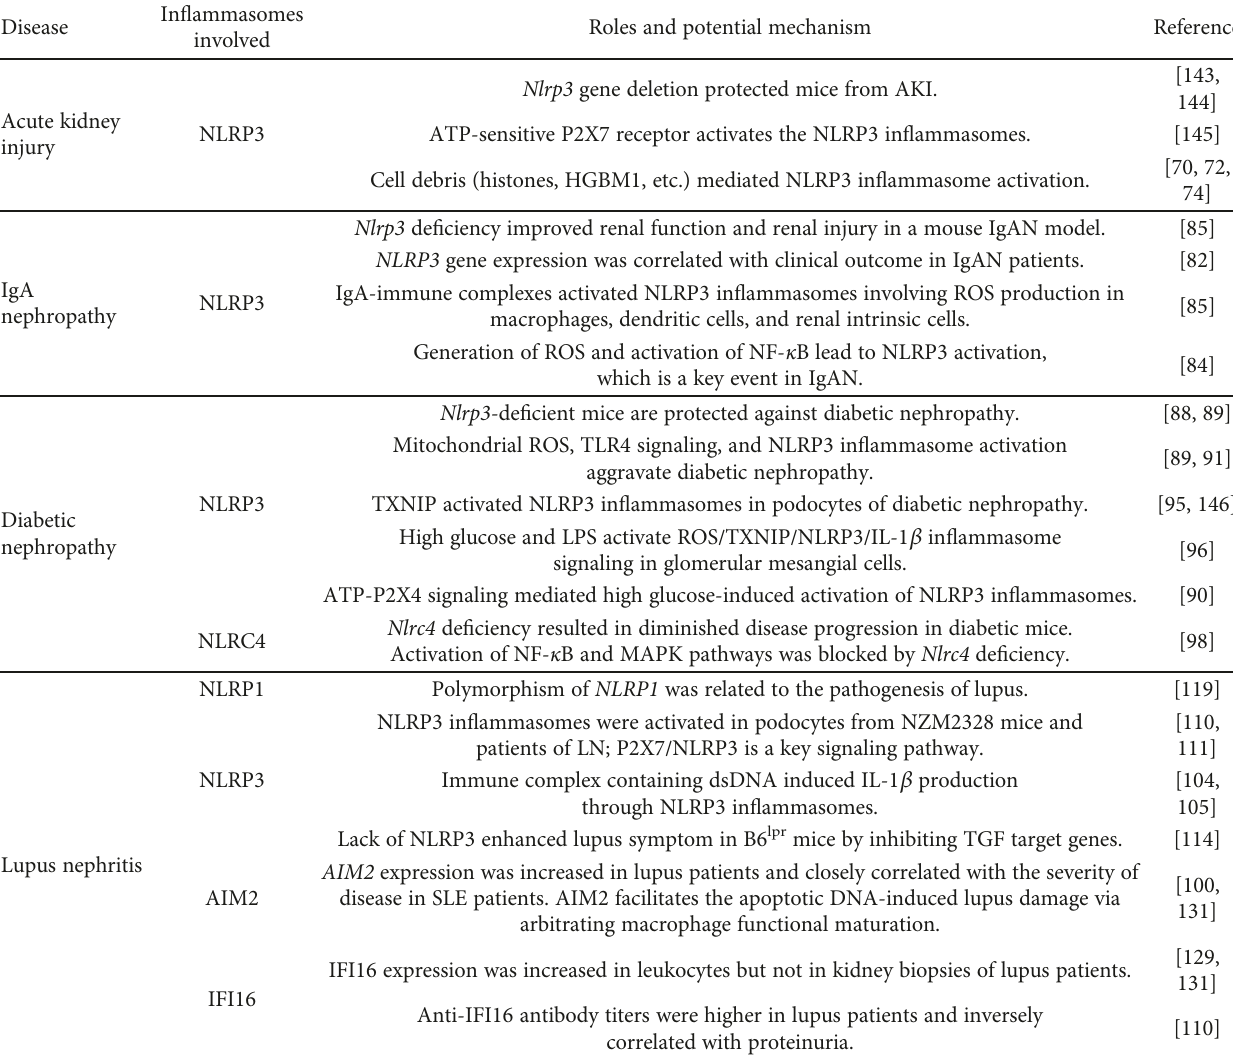
Table 1: Roles of in fl ammasomes in in fl ammatory kidney diseases.